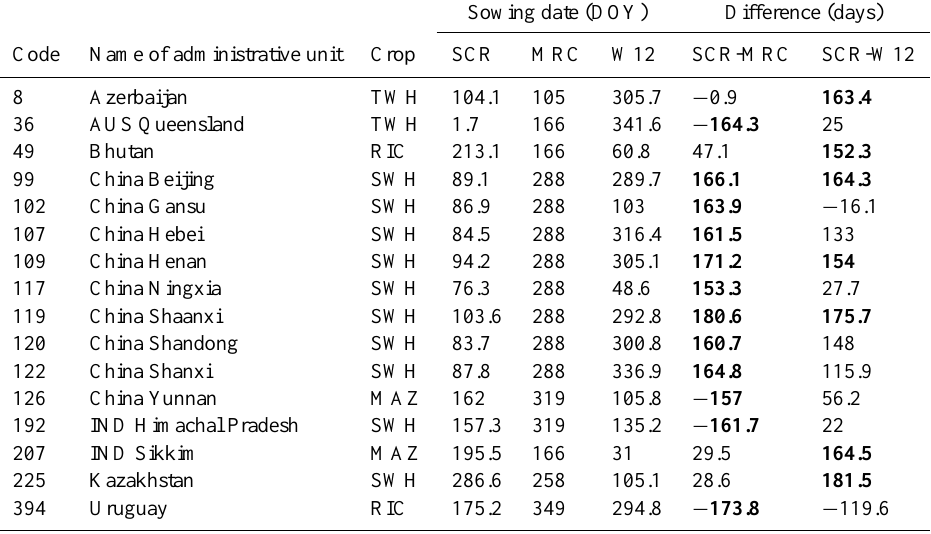
Figure 10. Differences in sowing dates of the dominant crop in the major cultivation season ( a : SACRA–MIRCA2000; b : SACRA–Waha et al., 2012). The administrative units are illustrated if their dominant crop in the major cultivation season is temperate-wheat, snow-wheat, maize, rice, soybean or cotton. The differences for each specific crop type are shown in Fig. A3. Only single cropping grids are used to compute the averaged sowing date for SACRA. Table 5. Administrative units with large absolute differences in sowing date (>150 days) between SACRA and MIRCA2000 or SACRA and Waha et al. (2012). SCR, MRC, and W12 in the table represent SACRA, MIRCA2000, and Waha et al. (2012), respectively. “Code” and “Crop” represent the assigned code of the administrative unit in SACRA and the dominant crop in the major cultivation season in this study. Bold numbers denote large absolute differences in sowing date between SACRA and the other data sets. The table compares sowing dates averaged over the administrative units. Only single cropping grids are used to compute the averaged sowing date for SACRA. Sowing date